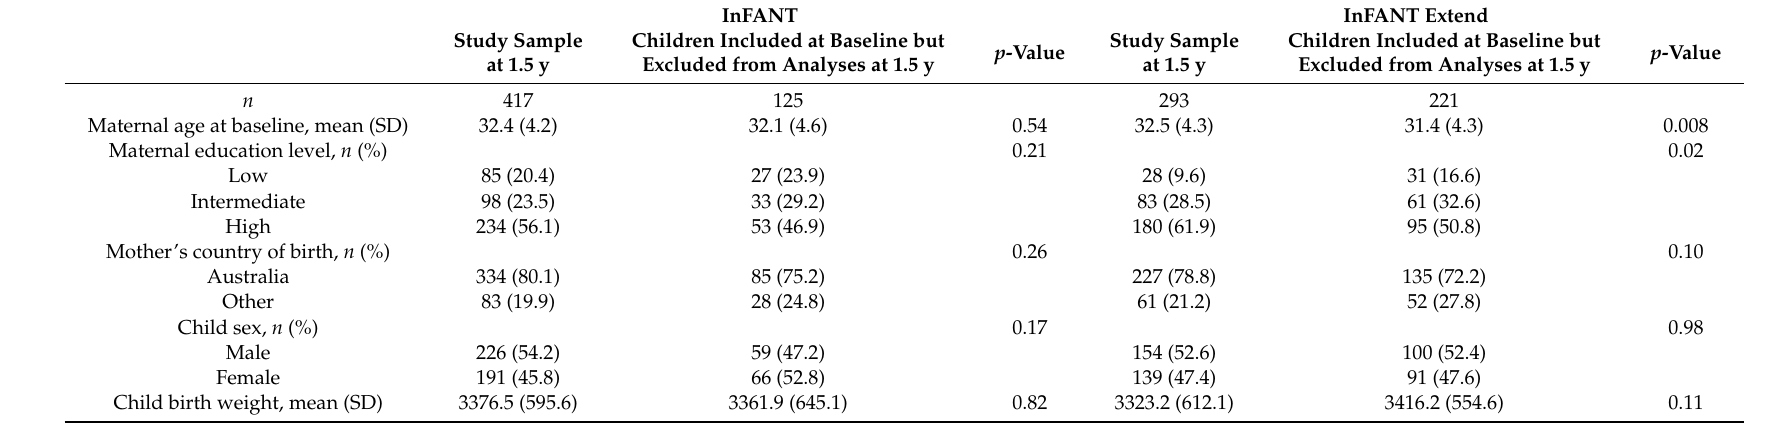
Table 1. Characteristics of the study